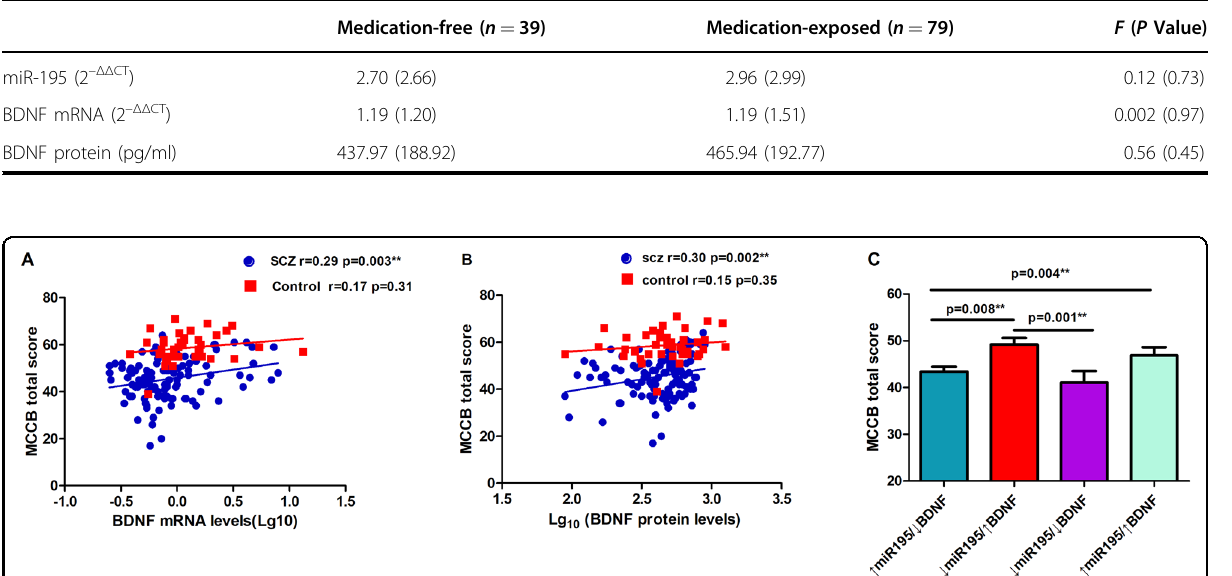
Fig. 2 BDNF mRNA levels and cognitive performance. A BDNF mRNA levels were signi fi cantly and positively associated with MCCB total score in patients with schizophrenia (SCZ) ( p = 0.003) but not in healthy controls. B BDNF protein levels were signi fi cantly associated with MCCB total score ( p = 0.002) in SCZ but not in healthy controls. C Patients with ↑ miR195/ ↓ BDNF had signi fi cantly lower cognitive performance compared to patients with ↓ miR195/ ↑ BDNF. **Signi fi cant after Bonferroni correction for eight cognitive measures.